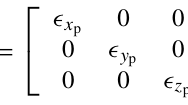
tion is a special case when A x = A y (cid:54)= 0 and ∅ = ± 90 ◦ and linear polarization is a special case when ∅ = 0 and A x and A y are not zeros, or when either A x or A y is